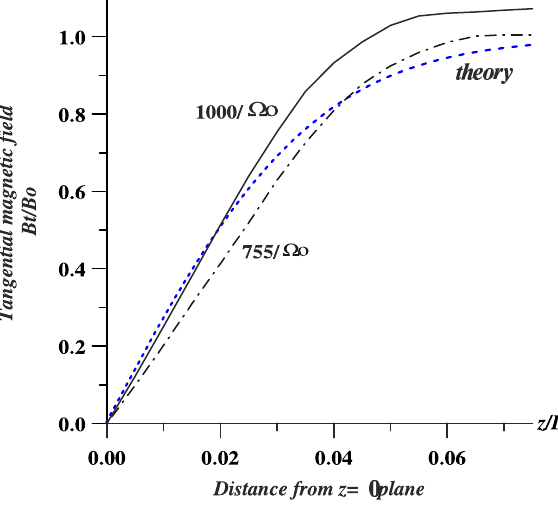
Fig. 3. Comparison of the magnetic field profile with the theoretical profile of the